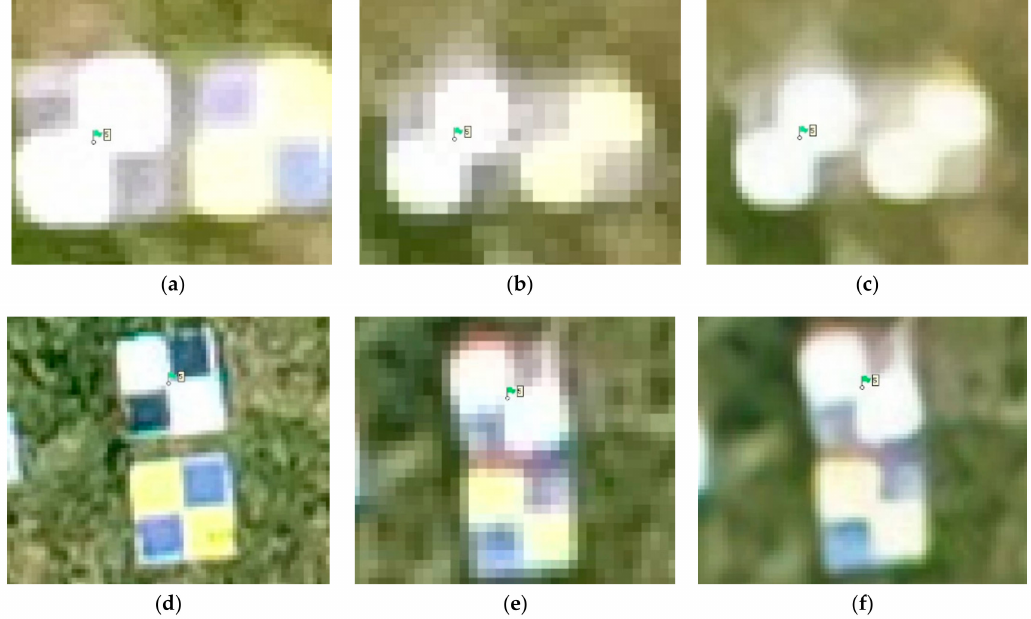
Figure 4. Images of ground-control points from the Mavic Pro: ( a ) GCP-5 at 55 m, ( b ) GCP-5 at 110 m, and ( c ) GCP-5 at SR and from the Phantom 4 Pro: ( d ) GCP-5 at 55 m, ( e ) GCP-5 at 110 m, and ( f ) GCP-5 at